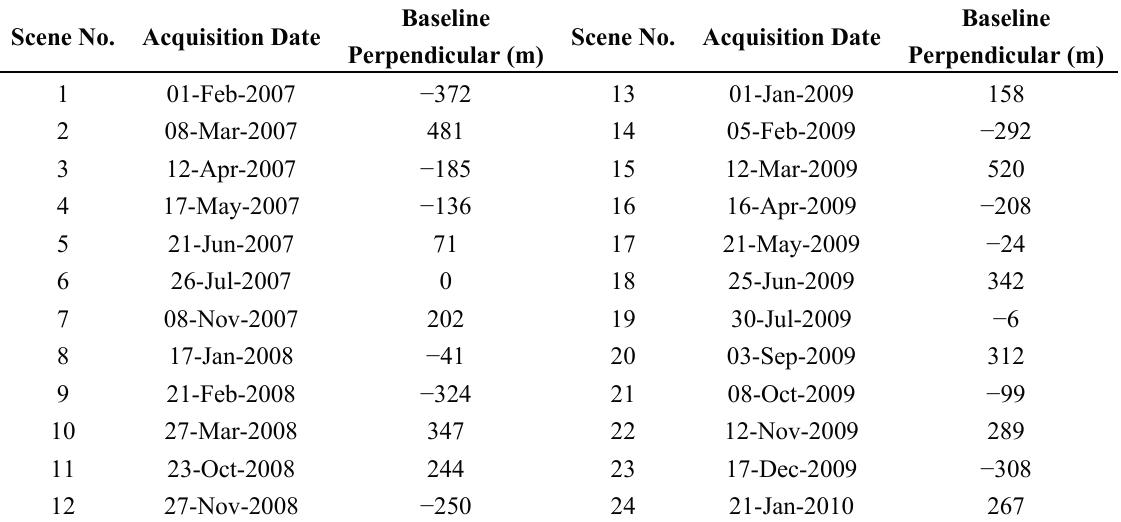
Table A1. SAR images used from Track 132 (Reference date: 26-Jul-2007). Scene No.